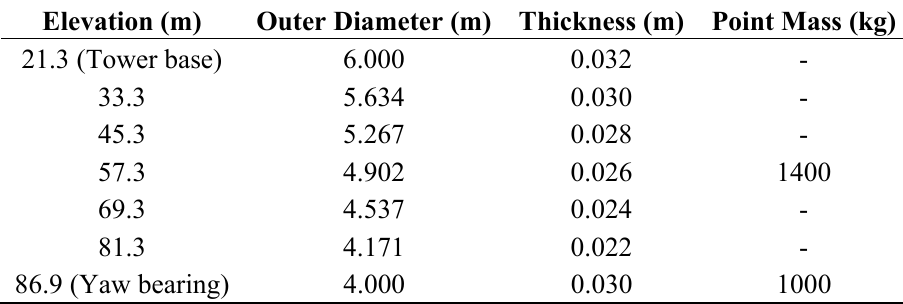
Table 3. Turbine tower section